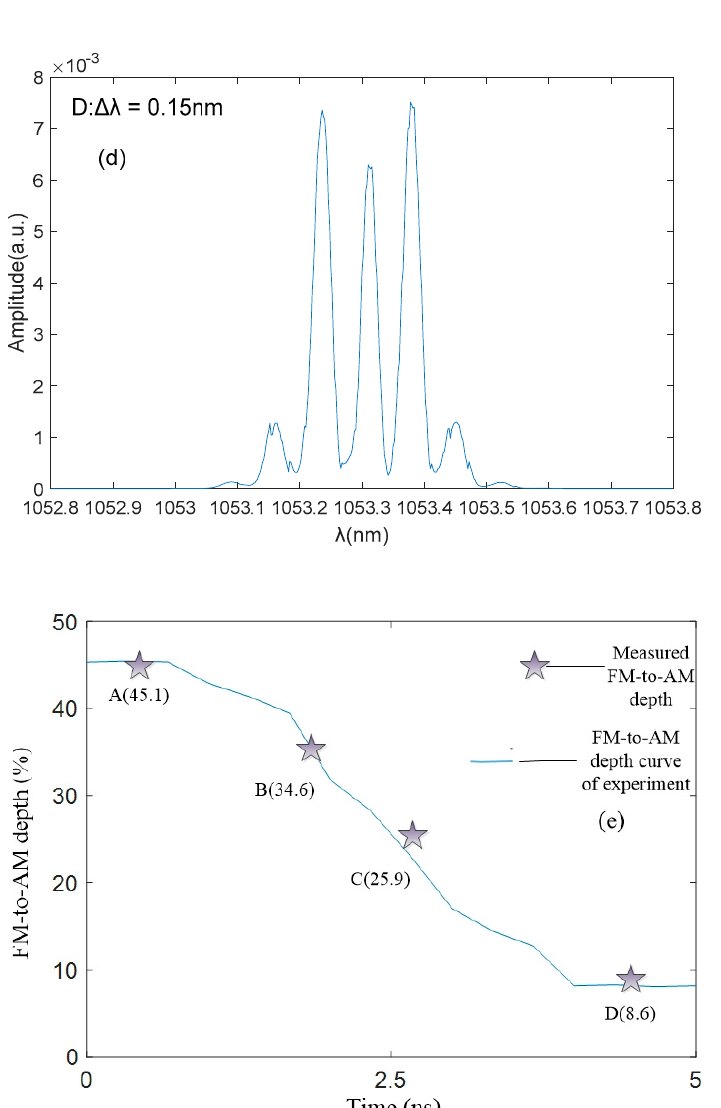
Figure 8. Experimental results of the inversion verification. ( a ) Spectral intensity with width of 0.53 nm. ( b ) Spectral intensity with width of 0.44 nm. ( c ) Spectral intensity with width of 0.30 nm. ( d ) Spectral intensity with width of 0.15 nm. ( e ) Measured FM-to-AM depth comparison with experimental